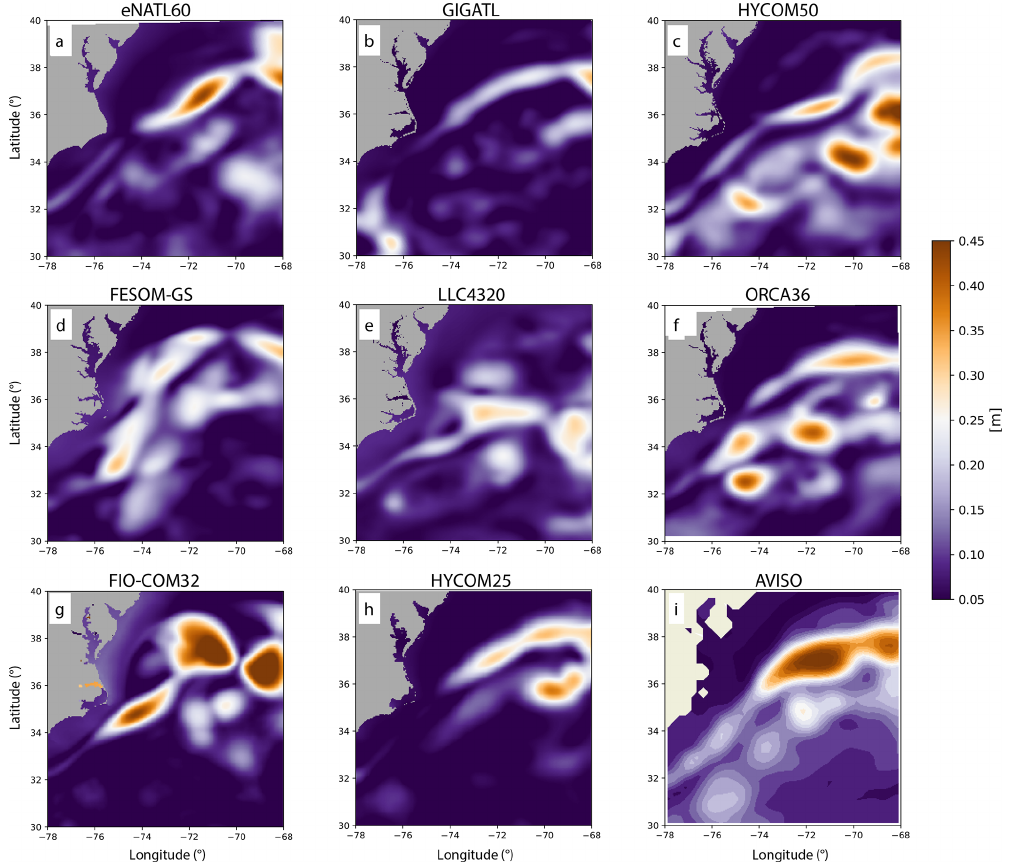
Figure C1. Temporal standard deviation of the spatiotemporally smoothed SSH from the eight models and ADT from AVISO over the years of 2010–2018 during the months of February–April. Note that the color bar is slightly adjusted from Fig. 3 in order to accommodate for lower